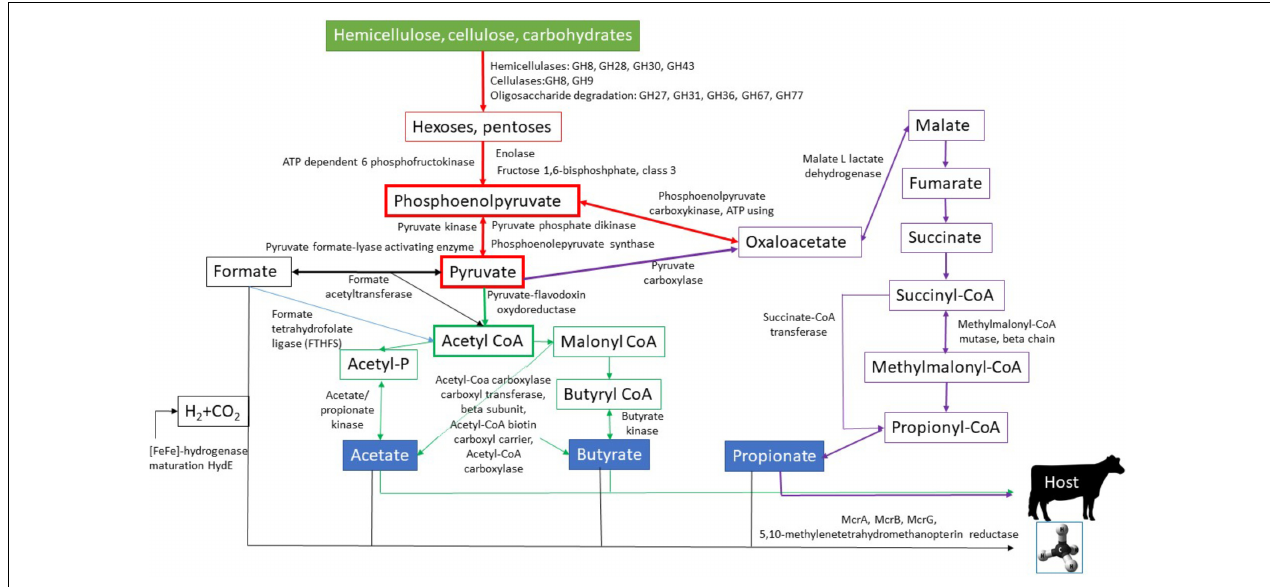
FIGURE 6 | Reconstituted metabolic pathways involved in the decomposition of complex carbohydrates in the rumen. The enzyme names next to the arrows indicate enzymes identified in this work and their position in the metabolic network. For details see Section “Core Functions and Their Associated